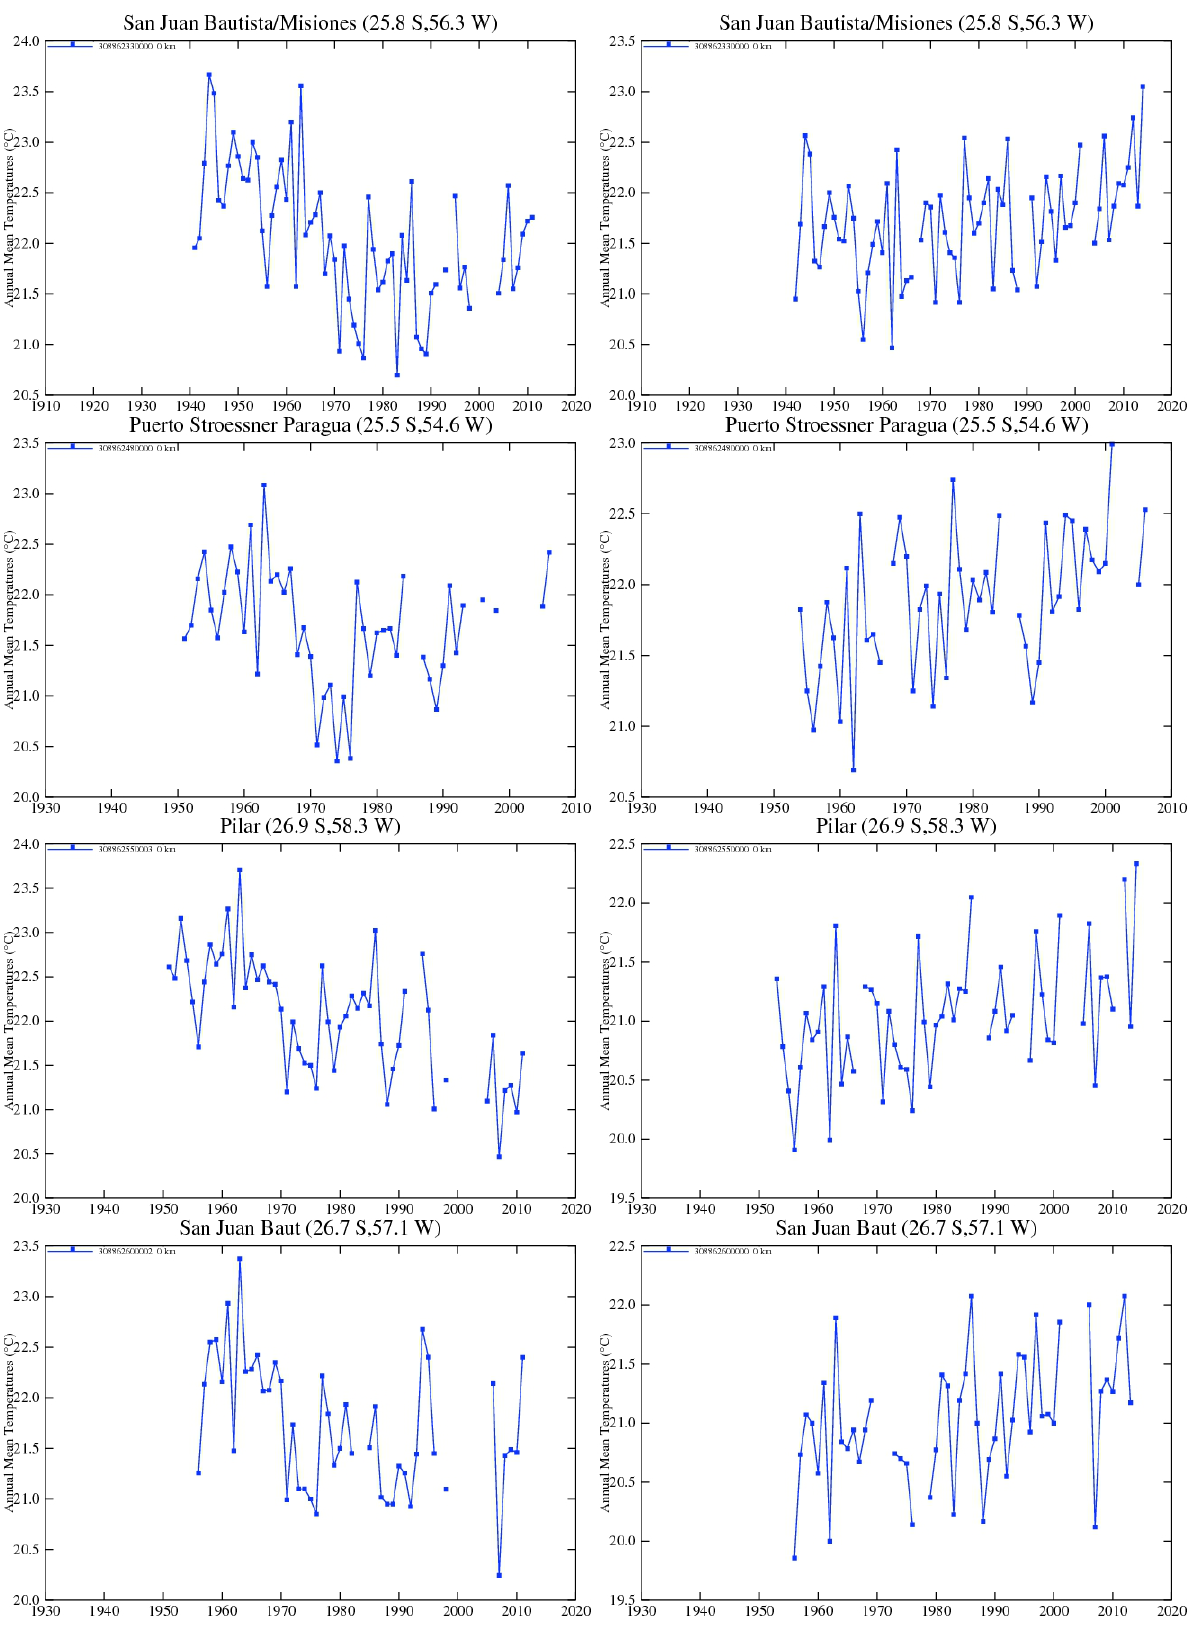
Fig. A.1: (Continued) GISS v2 vs. v3 temperature records for all the stations of Paraguay. In all cases coolings or no warmings have been transformed in significant warmings claiming impossible homogenization with previously massaged data. GISS v2 data on the left, GISS v3 data on the